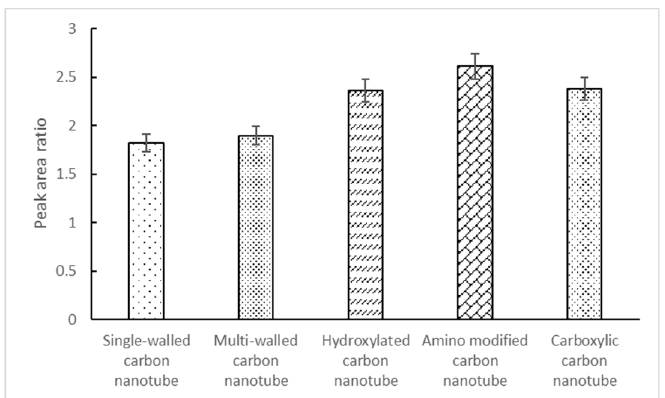
Figure 2. The comparison of absorption performance on 5 kinds of